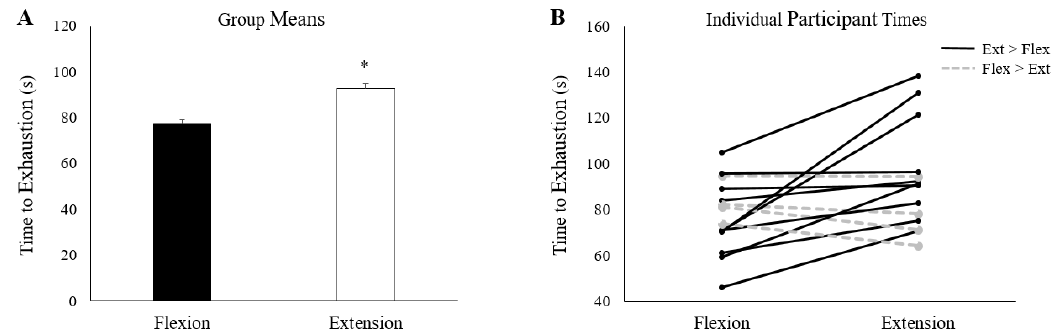
Figure 4. ( A ) Group averages of time to exhaustion. * denotes a significant difference between collection sessions. ( B ) Time to exhaustion for all 14 participants on both testing sessions. Black lines represent the 10 participants who took longer to reach the 25% cut-off on the extension day; grey dashed lines denote the 4 participants who took longer on the flexion day. Error bars in ( A ) represent standard error.